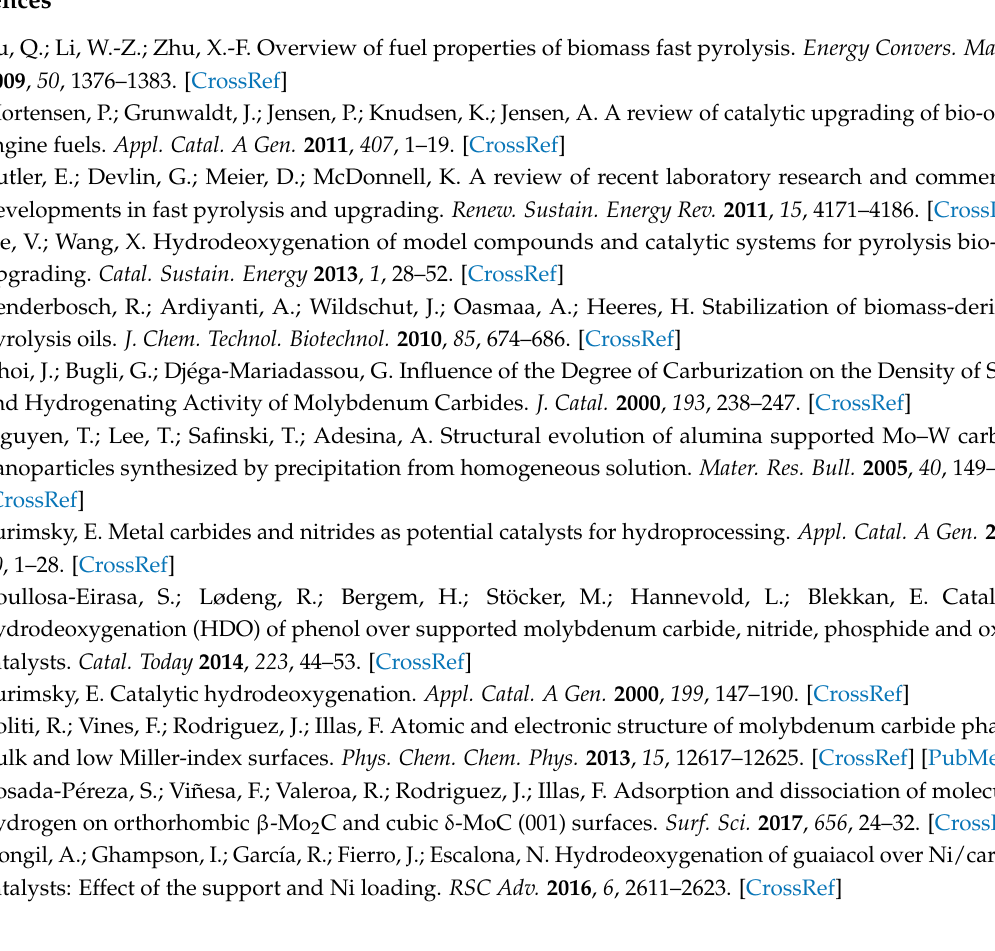
Table S1: Operating conditions, conversions and product selectivities during the hydrodeoxygenation of guaiacol over the Mo 2 C/CNF